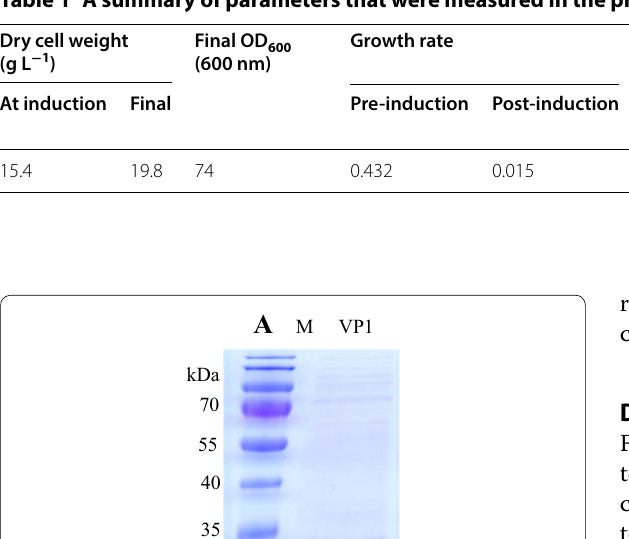
Fig. 3 A graph showing growth of EC-VP1 and glucose fed during the production of VP1 in fed-batch fermentations. Infors fermenters (n 1.5 L media were each inoculated with 100 mL of actively growing culture at an OD 600 of 0.6. The cultures were induced for protein production with